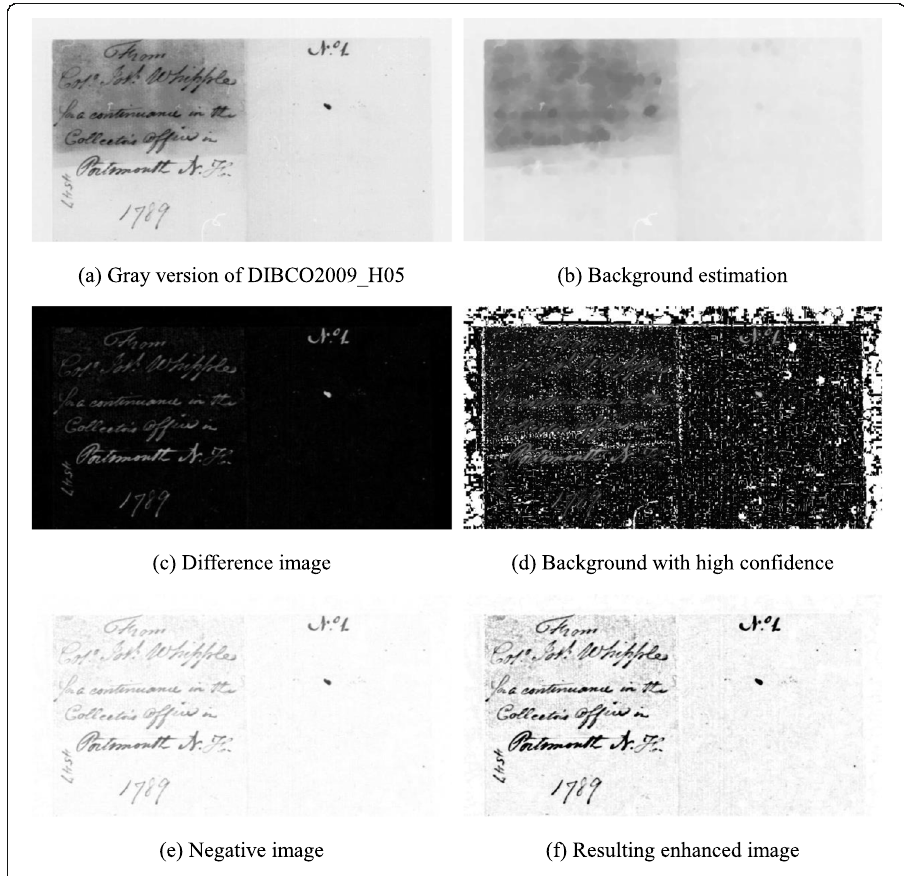
Fig. 5 Document background estimation and